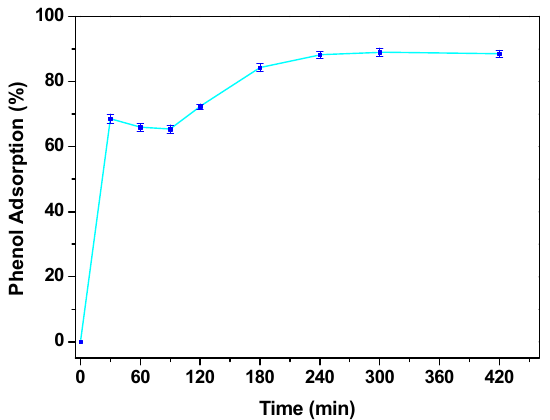
Figure 7. Phenol adsorption performance at C phenol = 4000 mg/L with HCL resin C Solid = 0.4 g/L.